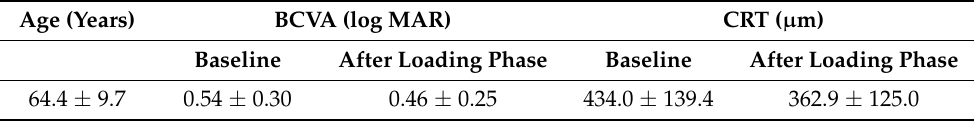
Table 1 . The demographics of all 72 patients. Table 1. The demographics of all 72 patients.